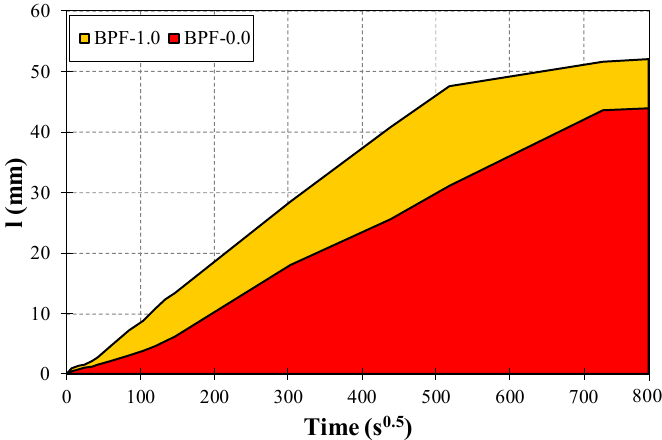
Figure 11. Representative areas under the capillary water absorption rate curves for BPF-1.0 and BPF-0.0 mixes.